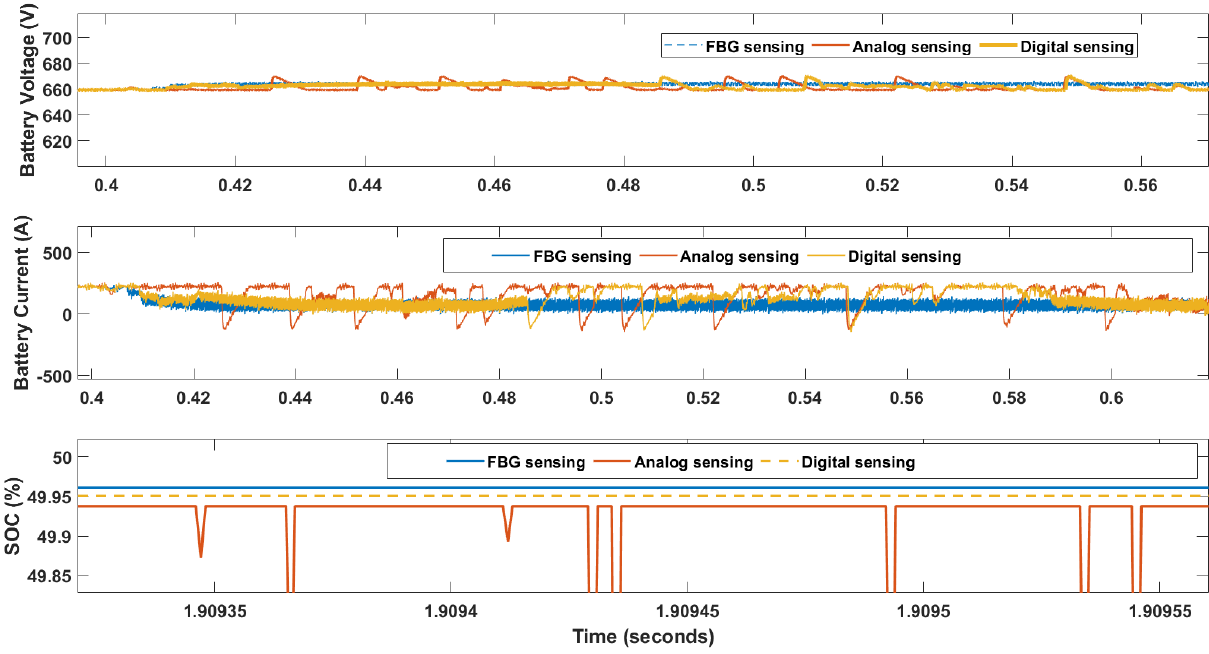
Figure 17. Output metrics at the potential point of the battery bank under EMI.